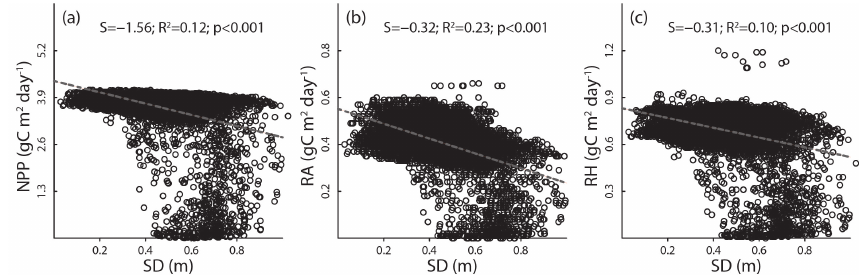
Fig. 9. The relationships of saturation deficit (SD) with (a) net primary productivity (NPP), (b) soil autotrophic respiration (RA), and (c) soil heterotrophic respiration (RH). Data shown here are based on the simulation considering water